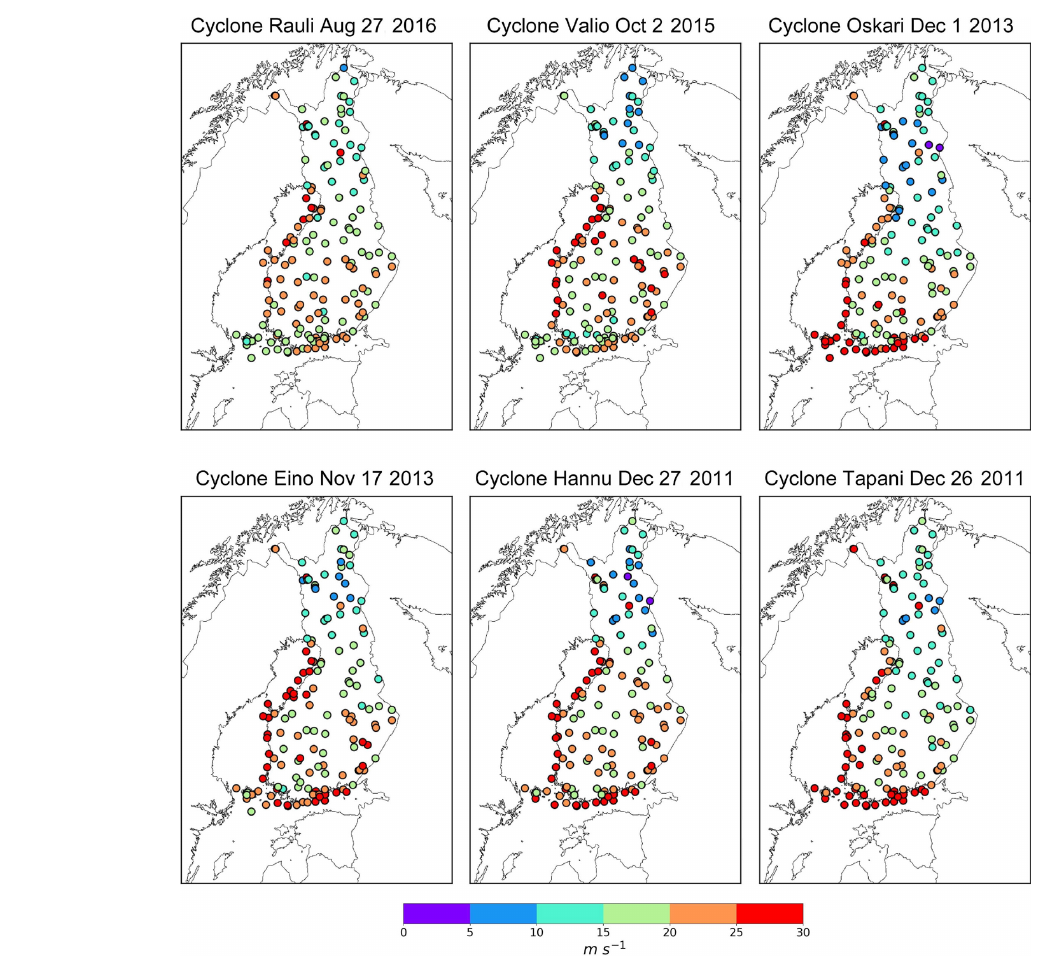
Figure 2. The maximum wind gust speed (ms − 1 ) observed at the stations operated by the FMI (coastal and fell stations included) associated with the six large-scale windstorms during the